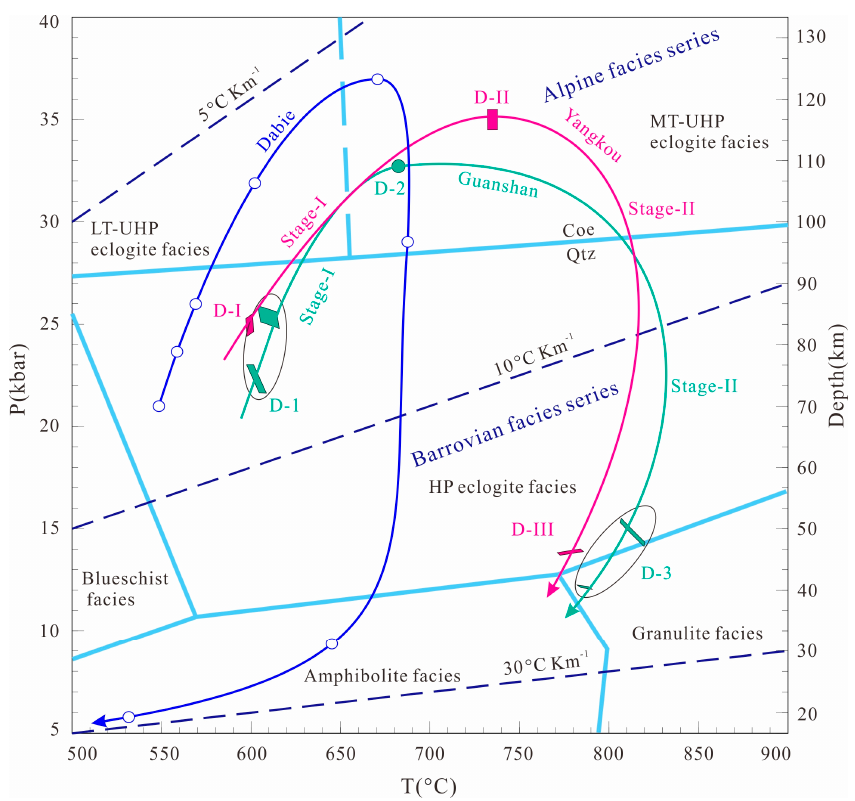
Figure 11. The summarized P-T conditions and paths for UHP S (Guanshan) and UHP N (Yangkou) eclogites. Stage-I and Stage-II refer to subduction and exhumation stages, respectively. Domain D-II is from Wang et al. [69] for the Yangkou eclogites. The P-T path labelled with “Dabie” is from Guo et al. [42,70] for the Hualiangting eclogites at Dabie. The boundaries of different metamorphic facies are cited